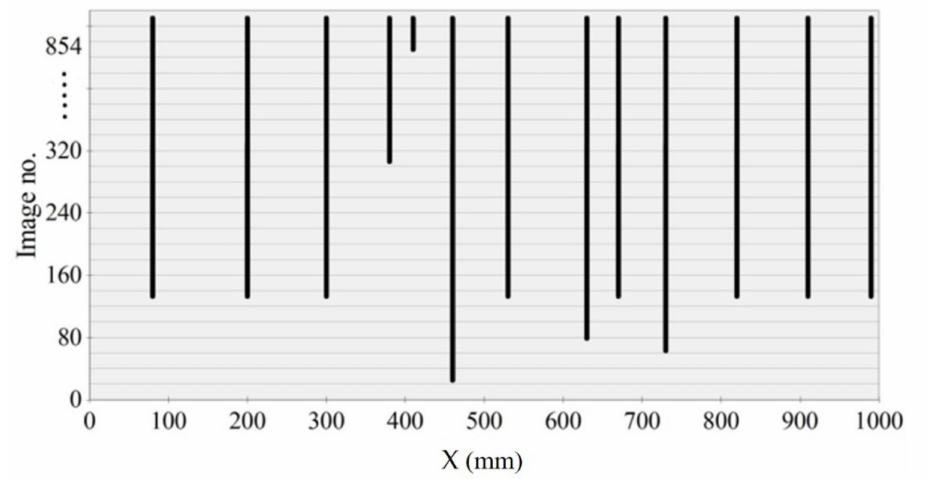
Figure 26. Crack formation and density under loading—beam